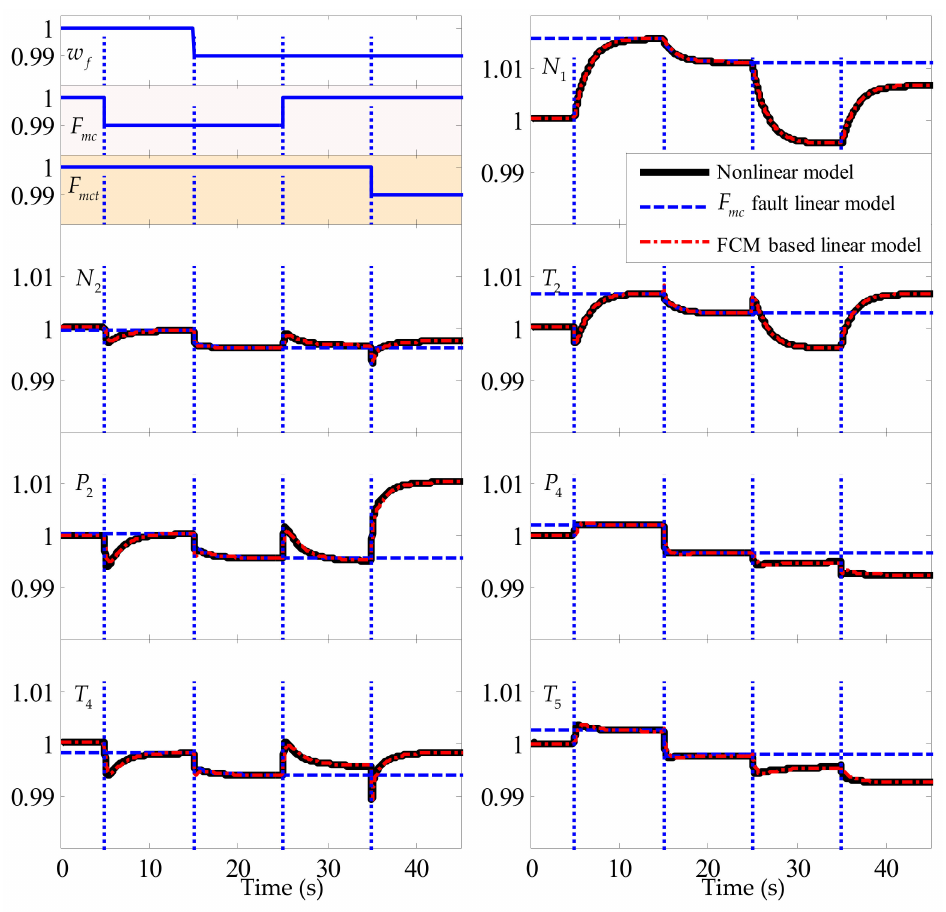
Figure 7. Performance comparison between the traditional F mc fault linear model at design operating points and the FCM based model